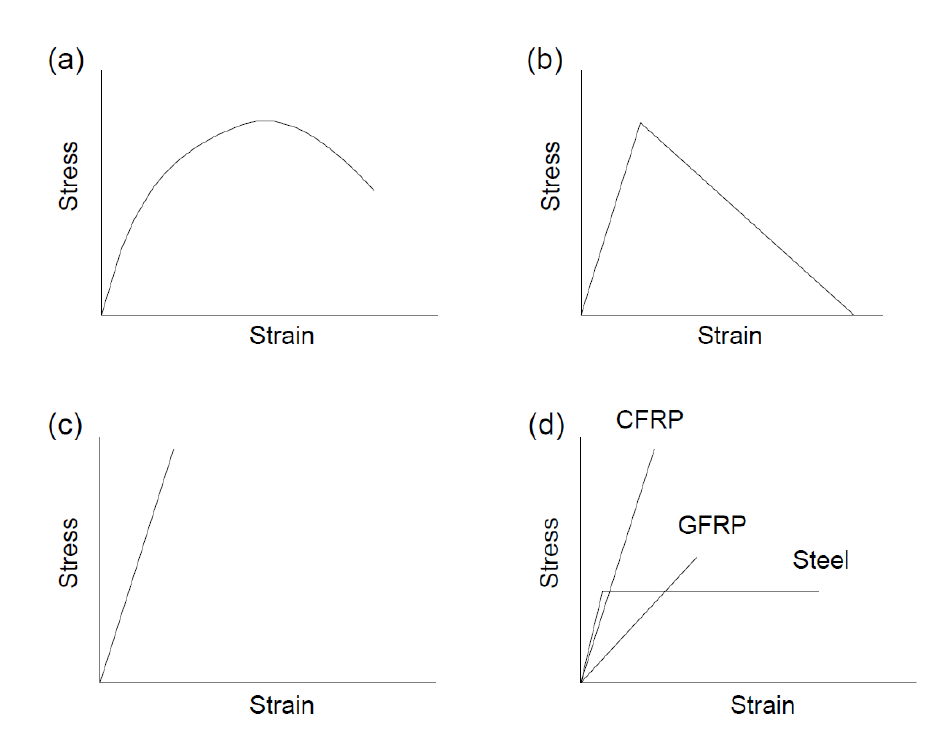
Figure 1. Beam element, u , v , and θ are the axial, transverse displacements, and rotation, respectively.